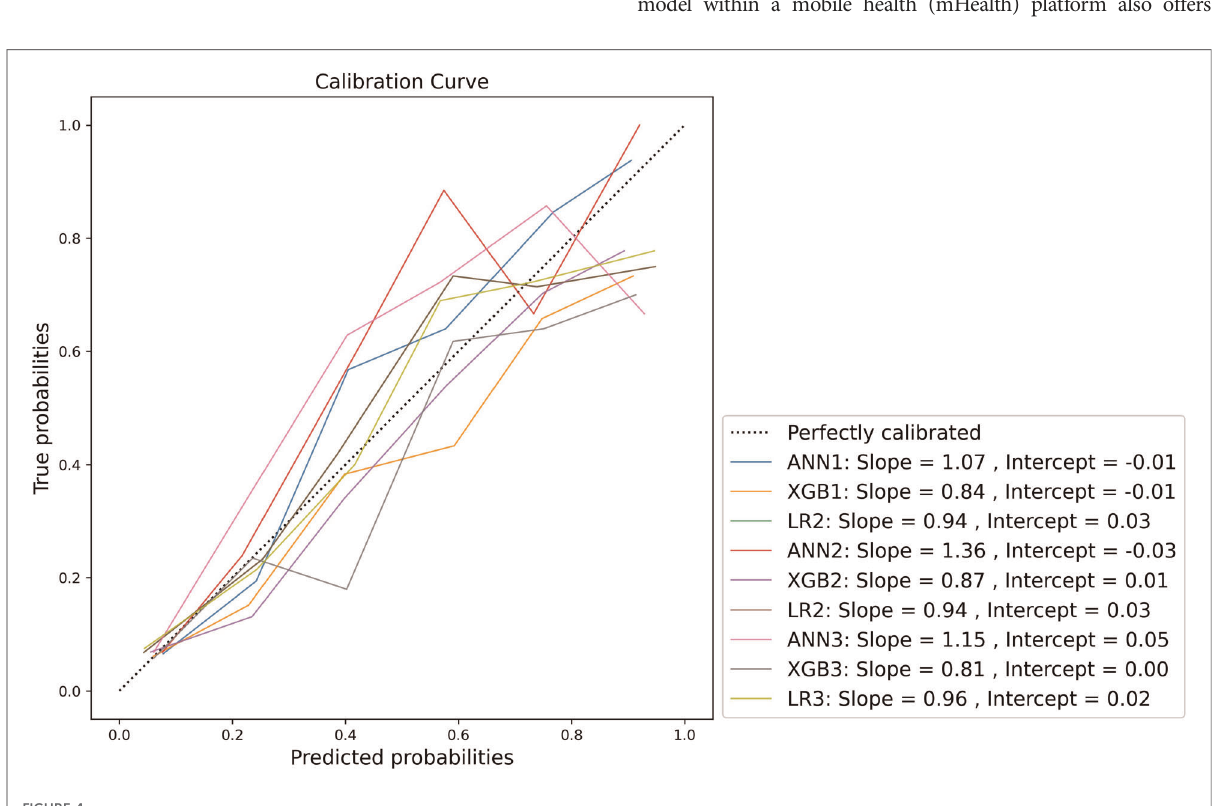
FIGURE 4 Normalised fl exible calibration